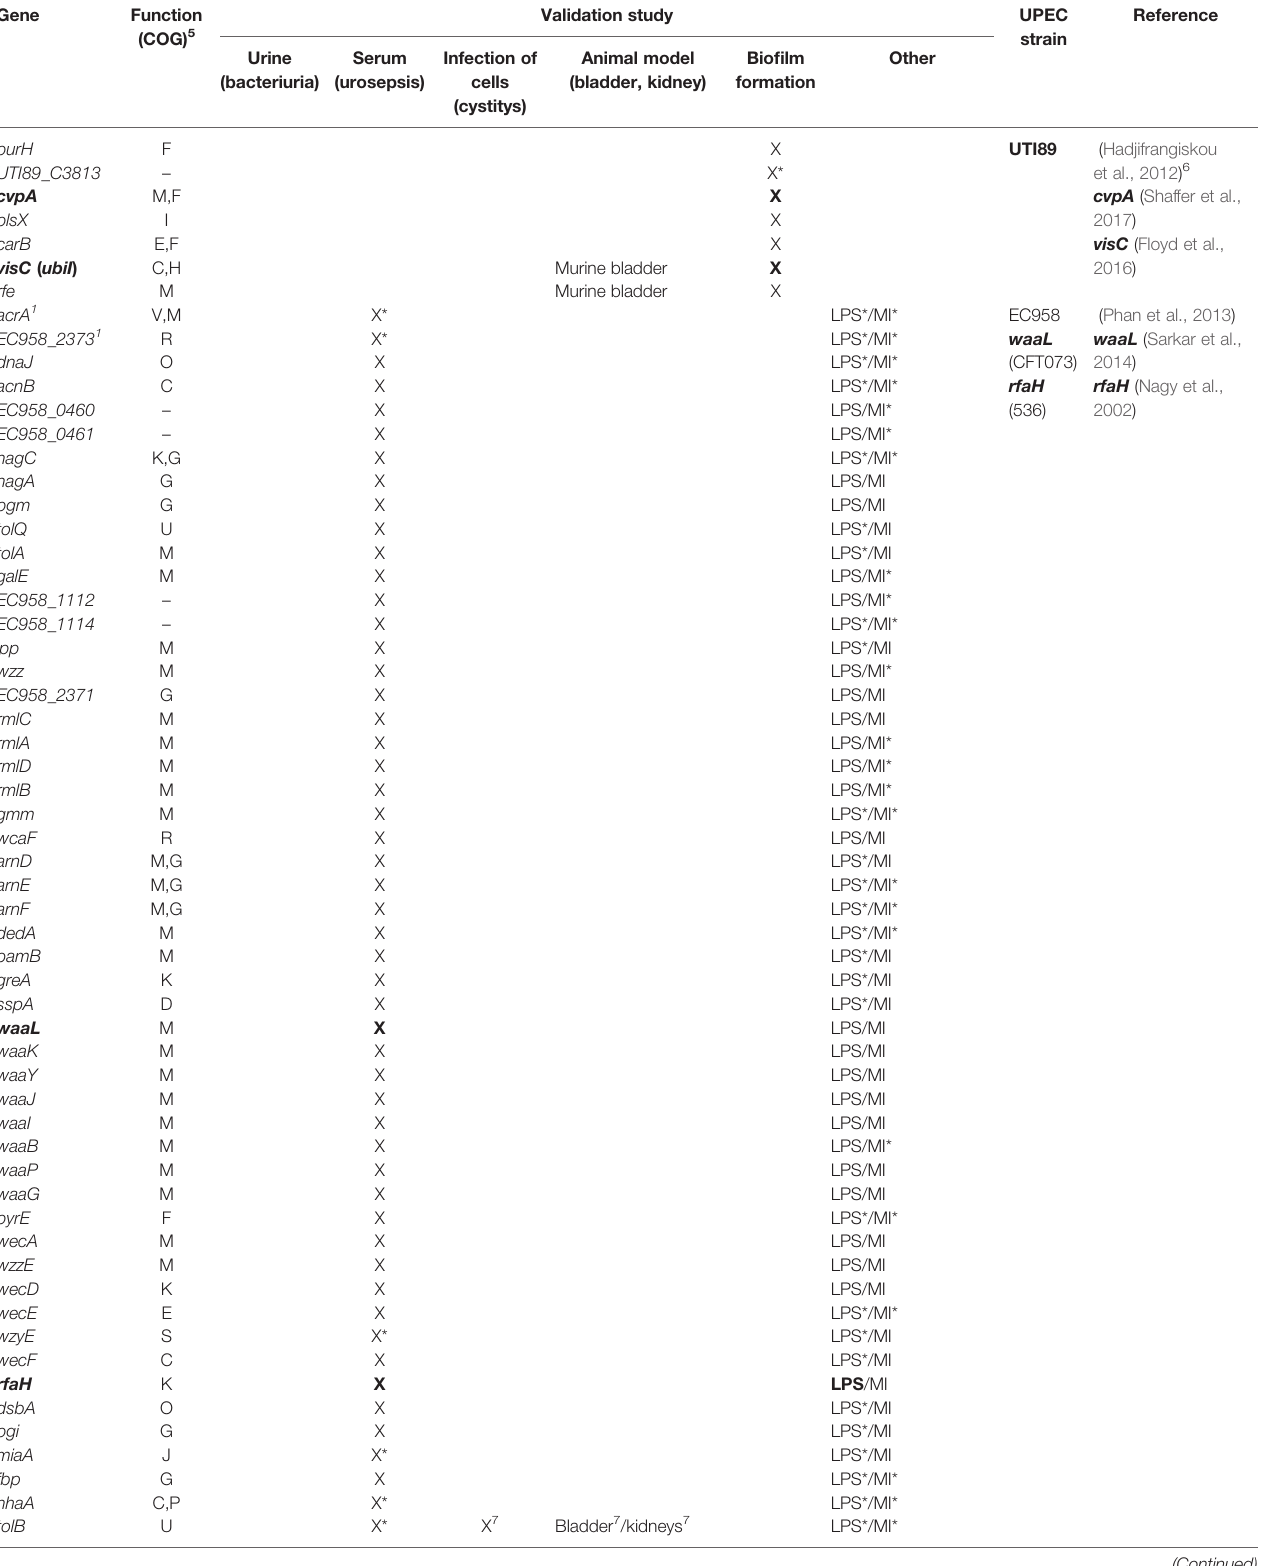
TABLE 1 | Validated genes identi fi ed by